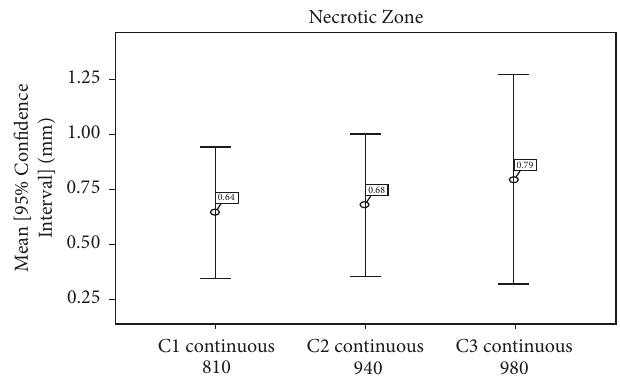
Figure 8: Average necrosis zones of groups C1, C2, and C3.